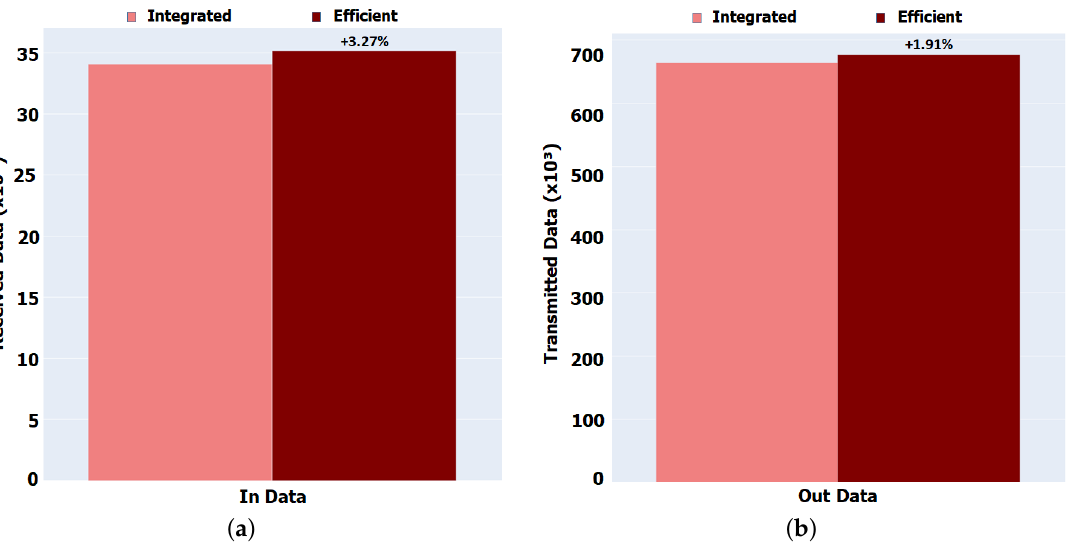
Figure 11. Global received and transmitted Data packets for Porto scenario. ( a ) In Data. ( b ) Out